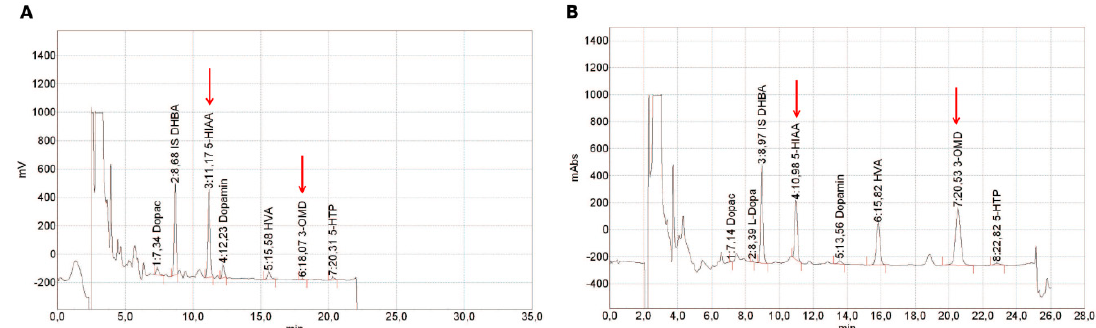
Figure A1. Example chromatogram of a TH-deficient patient. ( A ) An example chromatogram of a patient suffering from TH-deficiency, as shown by the reduced levels of 3-OMD and HVA. ( B ) A chromatogram of the same patient three months after initiation of the therapy. The level of HVA